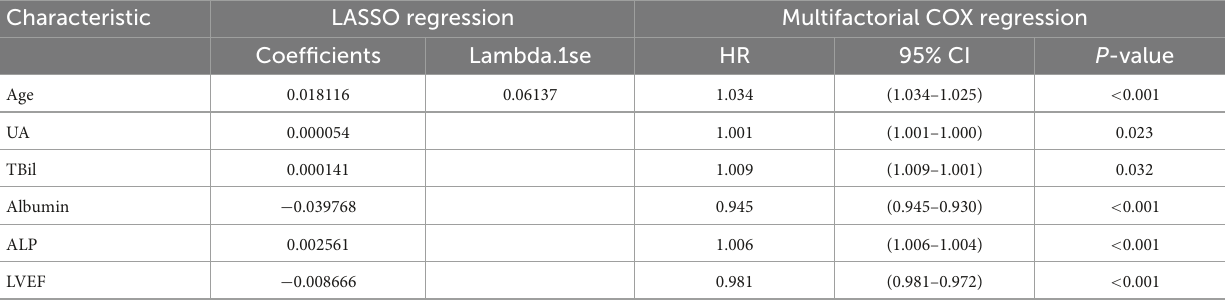
TABLE 2 Based on the coefficients and Lambda.1se values of the LASSO regression of the training set, multifactorial COX regression to validate the validity of each variable. Characteristic LASSO